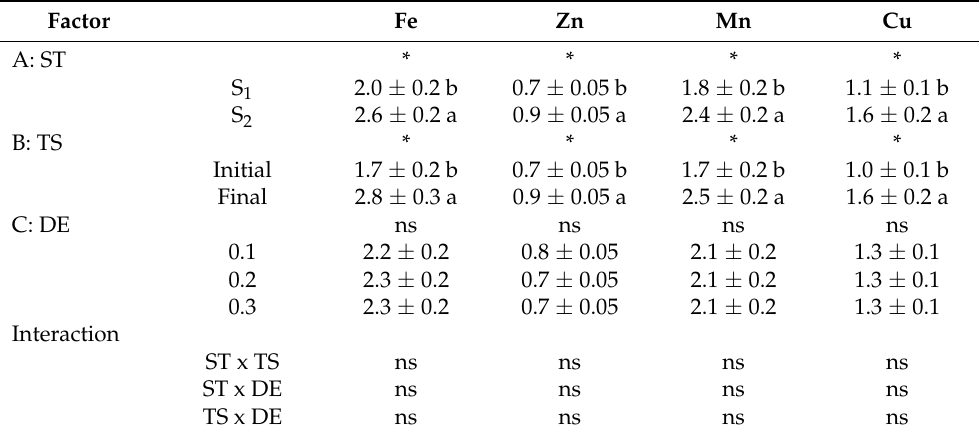
Table 2. Average concentration of Fe, Zn, Cu, and Mn (mg kg − 1 ) in sand layer and the interaction between the different factors. Soil type (ST), time sampling (TS), and distance of the sample from the emitter (DE).